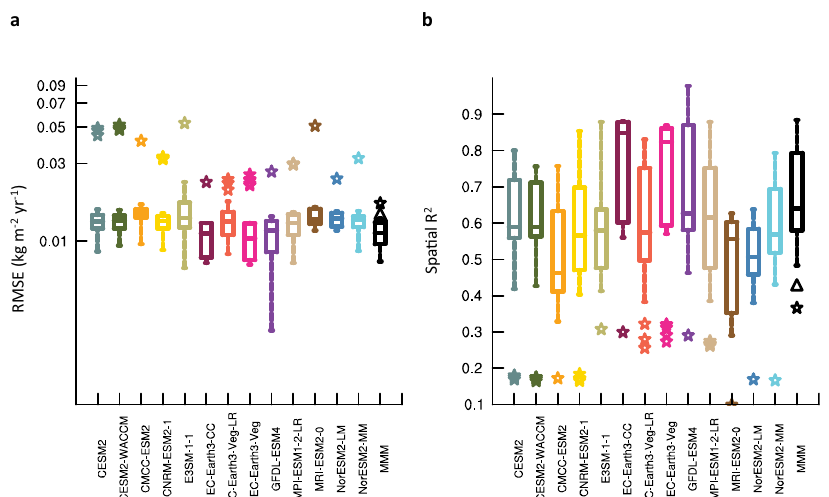
Fig. 2 Accuracy of historical fi re carbon emissions during 2007 – 2016 simulated by 13 Earth system models (ESMs) without and with the observational constraint. a Root mean square error (RSME) (kg m − 2 yr − 1 ) between the observed, decadal mean global fi re carbon emission and the original (star representing each ensemble member) and observation-constrained (boxplot, representing the 10th, 25th, 50th, 75th, and 90th percentiles in the multi – data set ensemble) simulations from 13 ESMs and their multimodel mean. b Squared spatial correlation (R 2 ) between the observed, decadal mean global fi re carbon emission and the original (stars) and observation-constrained (boxplot) simulations from each of the 13 ESMs and their multimodel mean. The black triangles in a and b indicate the RMSE and R 2 produced by the traditional emergent constraint (EC) approach that constrains fi re carbon emissions during 2007 – 2016 with fi re carbon emissions during 1997 –